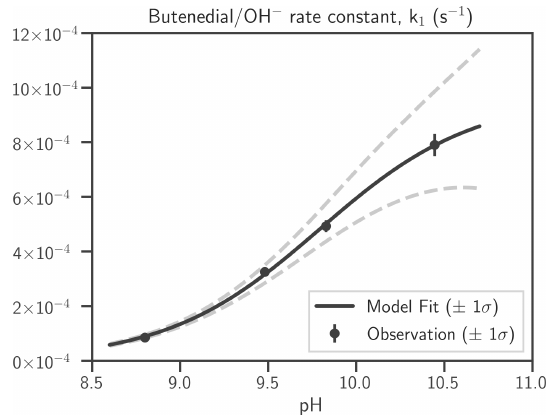
Figure 2. The butenedial/OH − rate constant versus pH is shown. Observed k 1 are from kinetic fits to butenedial decay measured through four BD/OH − experiments each held at constant pH. A fit to the empirical formulation of Fratzke et al. (1986) shows good agreement for all